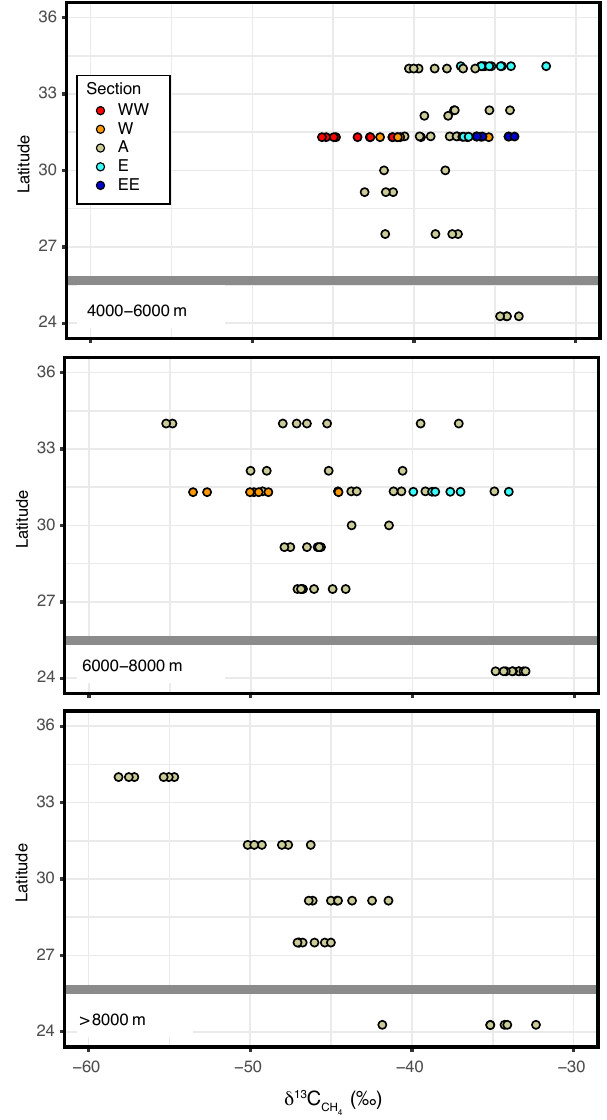
Figure 5. Spatial distribution of δ 13 C CH classified by color according to relative locations on the trench axis. Long horizontal bars indicate the boundary between the Izu– Ogasawara and Mariana trenches: the Ogasawara Plateau.